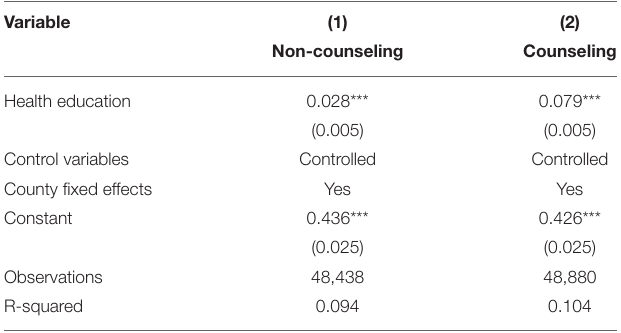
TABLE 7 | The effect of different health education methods on medical service utilization of the migrants. Variable